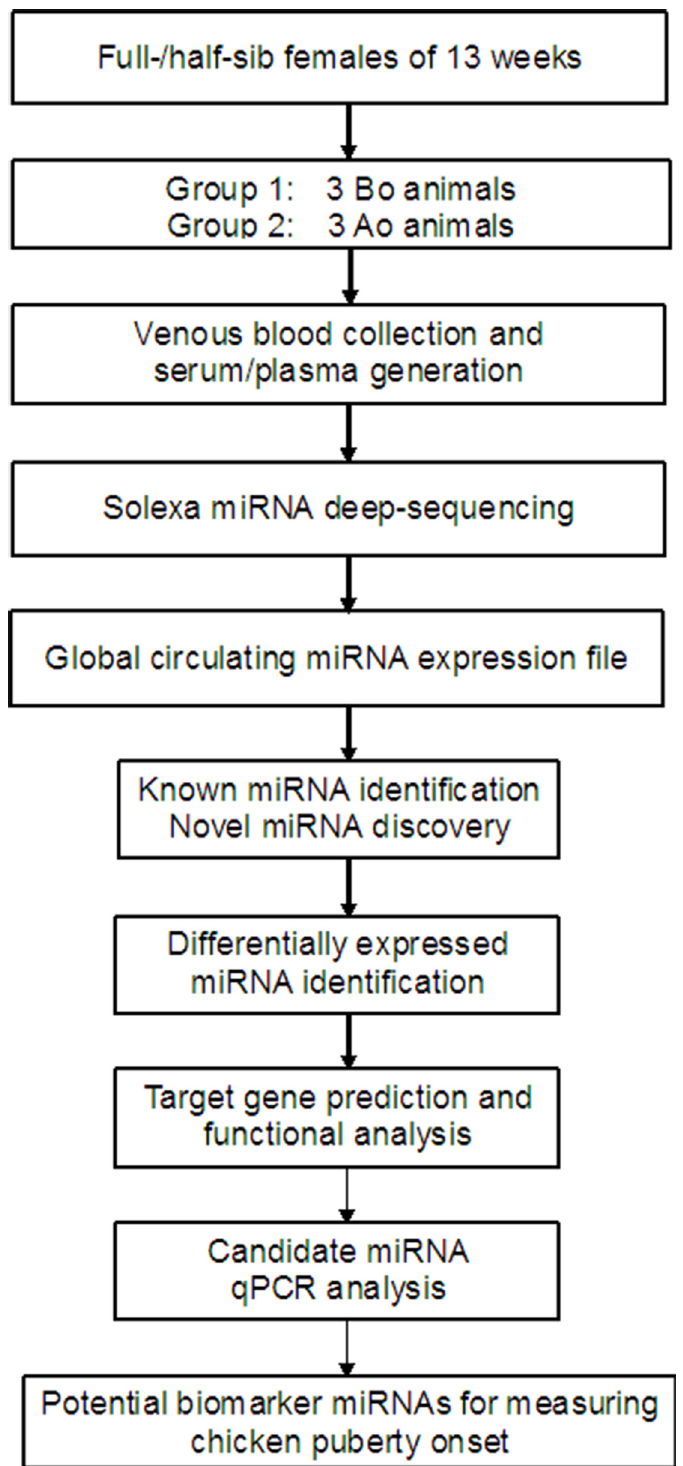
Fig 1. Global work chart of identification of potential circulating miRNAs for measuring chicken puberty onset. BO, before puberty onset; AO, after puberty onset.